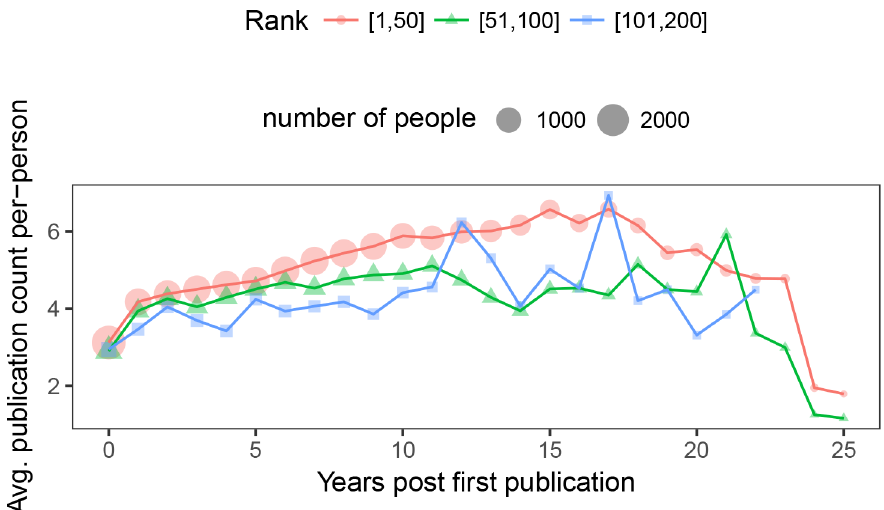
Figure 6 - Average trajectories of researchers in top 50 institutions with career length of 10 to 25 years follow a peak-decline